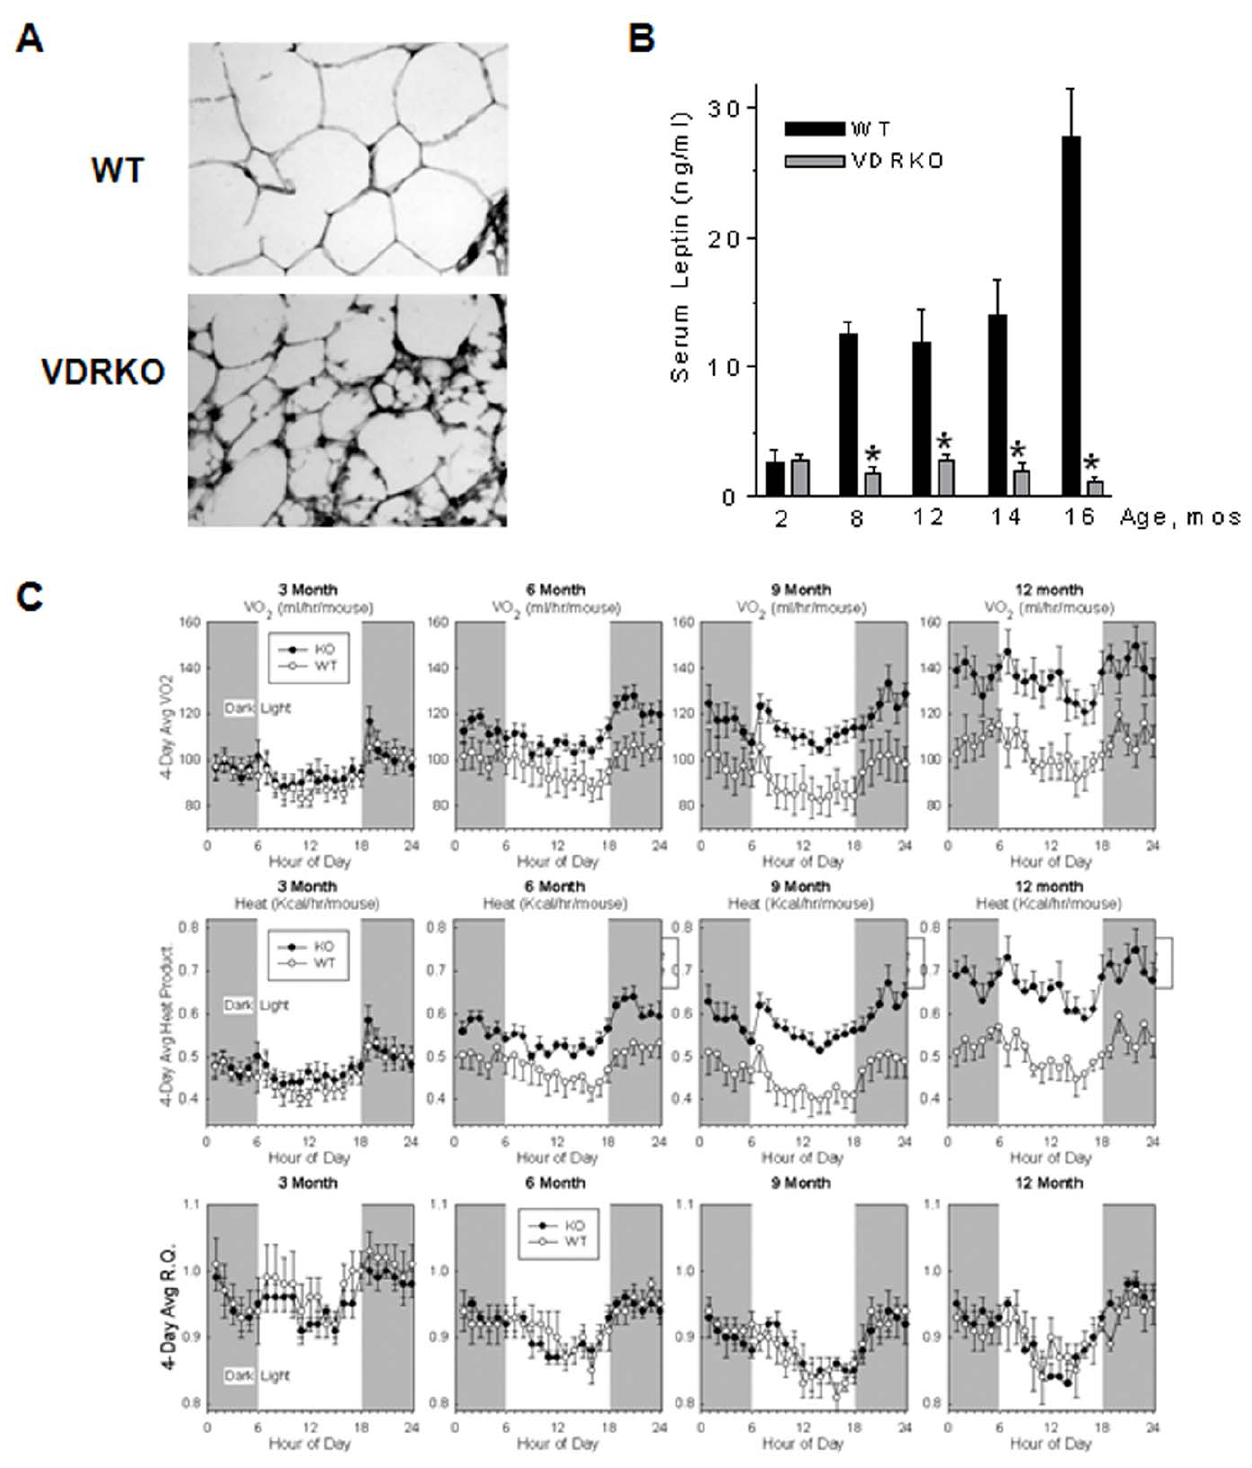
Figure 4. Adipose morphology and indirect calorimetric assessment throughout the aging of VDR WT and KO mice. A. Histological sections stained with hematoxylin and eosin Y show the small multi-locular adipocytes in glands of 16 month VDR KO mice compared to the large uni-locular fat cells in WT mice. B. Serum leptin was assessed by ELISA. There was a significant reduction in serum leptin by 8 months of age in the VDR KO mice that persisted through 16 months of age as a result of WT mice experiencing a progressive elevation in serum leptin beginning at 6 months and peaking at 16 months. C. Indirect calorimetric measurements were conducted every three months (3–12 months) in VDR WT and KO mice. Average oxygen consumption (VO 2 ) was trending higher by 6 months in VDR KO mice and was significantly elevated at 9 and 12 months compared to VDR WT mice. n=6 p , 0.05. Energy expenditure (Heat Kcal/hr/mouse) was similar to VO 2 in that VDR KO mice experience a significant elevation in energy expenditure by 9 and 12 months. n=6 p , 0.05. Respiratory exchange ratio (RQ), which infers the energy source utilized by the animal, was equivalent between VDR WT and KO mice throughout the aging time course (3–12 months).